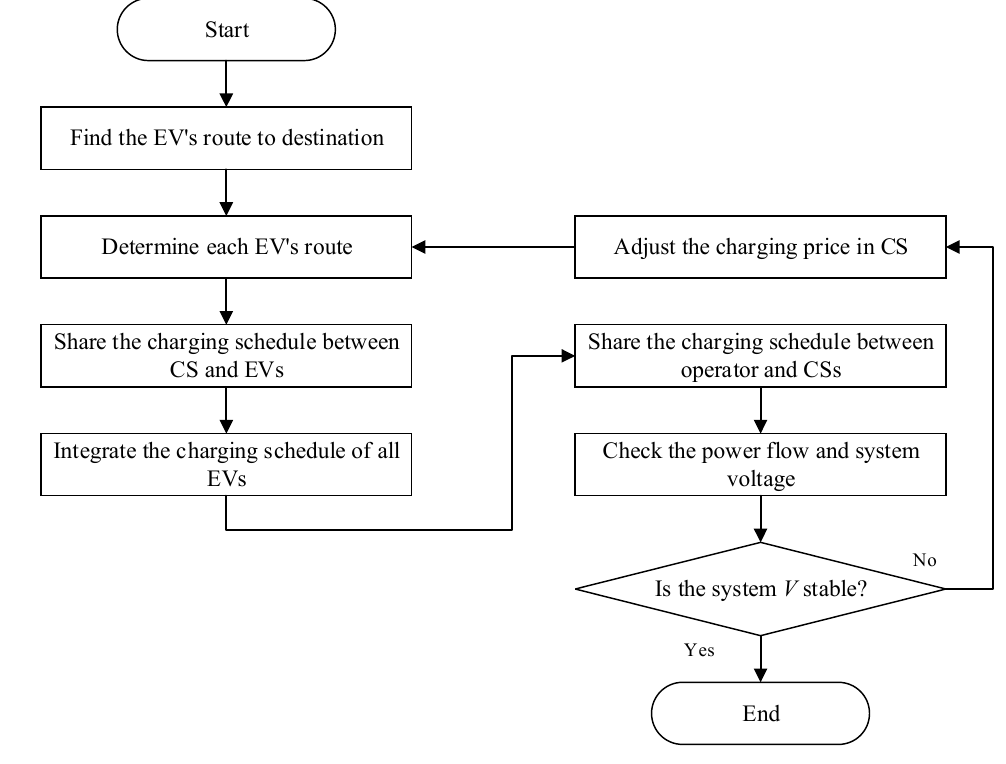
Figure 3. Flowchart of the system operator.